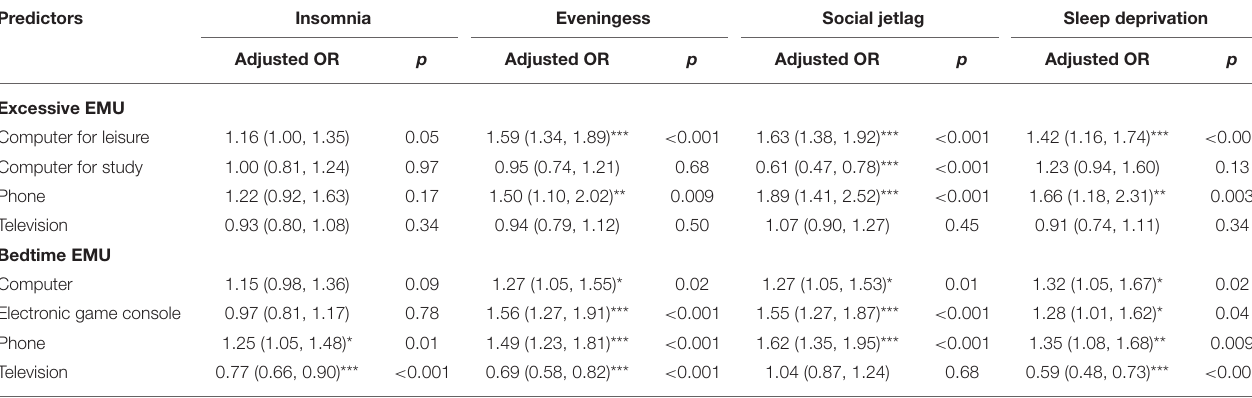
TABLE 3 | Comparison of the effects of excessive and bedtime EMU of different electronic devices on sleep and circadian problems. Predictors